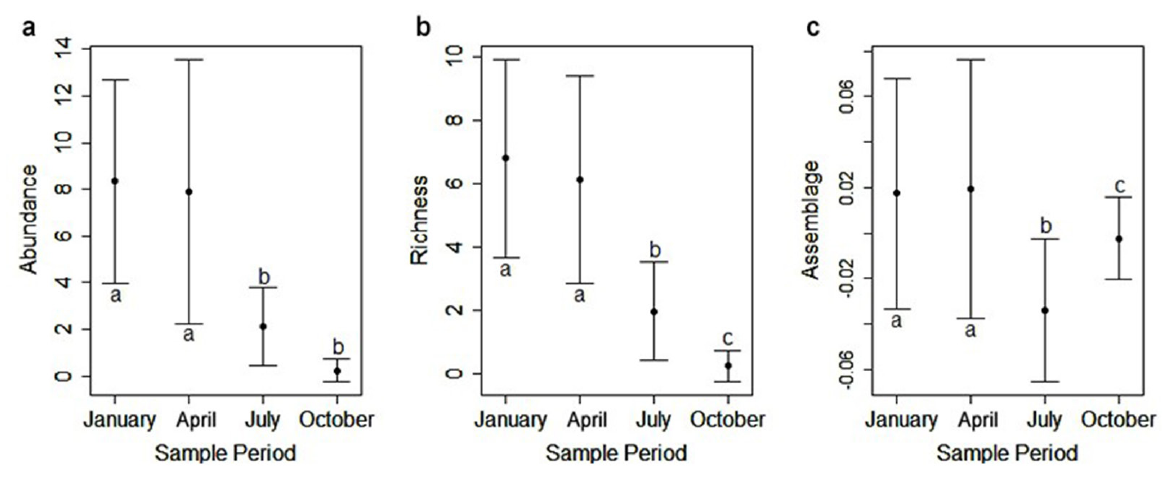
Figure 4. Comparisons of abundance (a), richness (b) and assemblage of Hymenochaetales and Polyporales (c) collected in the near the Silvio Braga HPP, in Western Pará between sample periods. Letters on the standard deviation bars indicate significant differences between pairs. Table III. Analysis results of environmental variables variance between sample periods. SQ = Quadratic sum, df